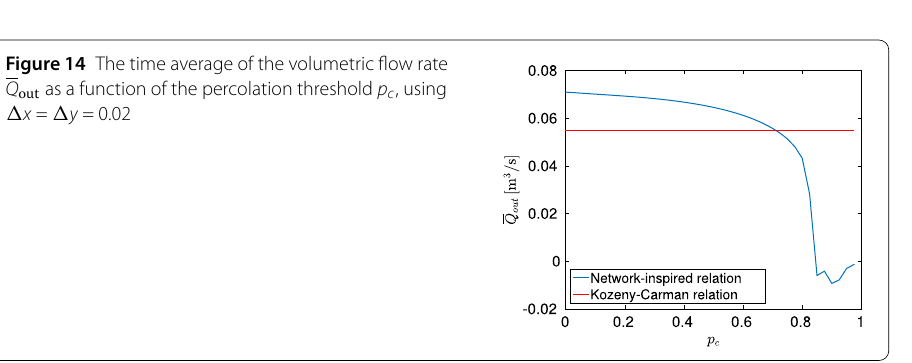
Figure 14 The time average of the volumetric flow rate Q out as a function of the percolation threshold p c , using (cid:9) x = (cid:9) y =